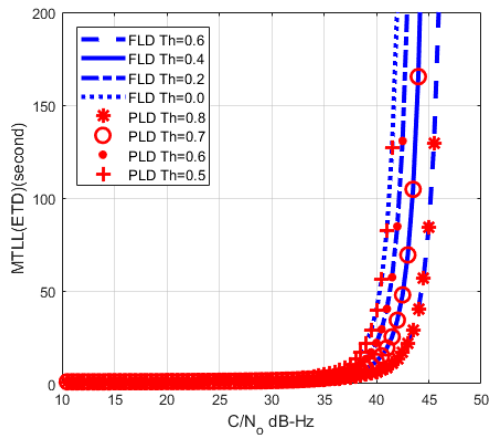
Figure 12. MTLL comparison between FLD ( M = 1) and PLD.